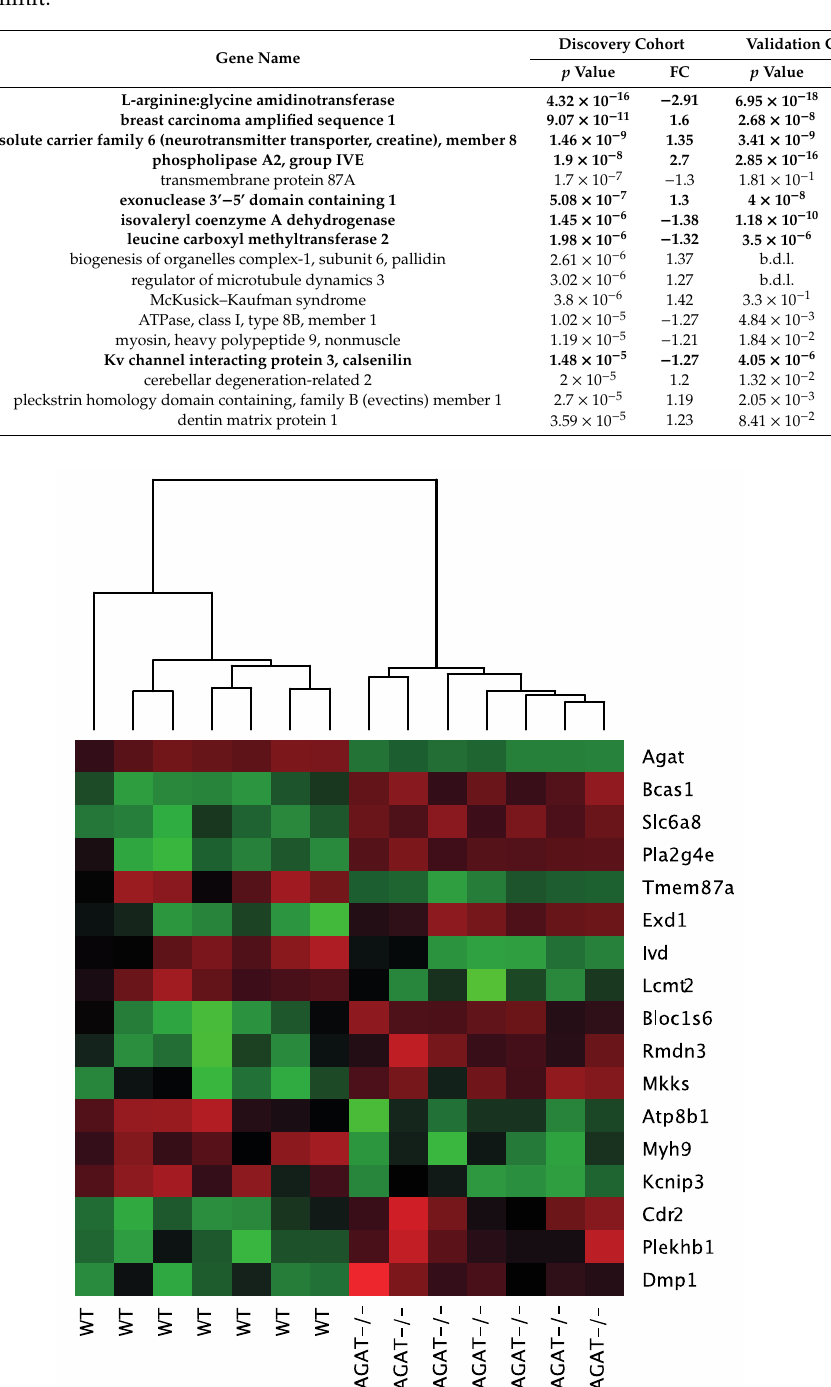
Table 1. Di ff erentially expressed genes between WT and AGAT − / − mice in brain tissue. p values and fold changes (FC) are given for the discovery cohort and the validation cohort. False discovery rate ≤ 0.05. Significantly regulated genes in both cohorts are written in bold. Abbreviations: b.d.l., below detection limit.